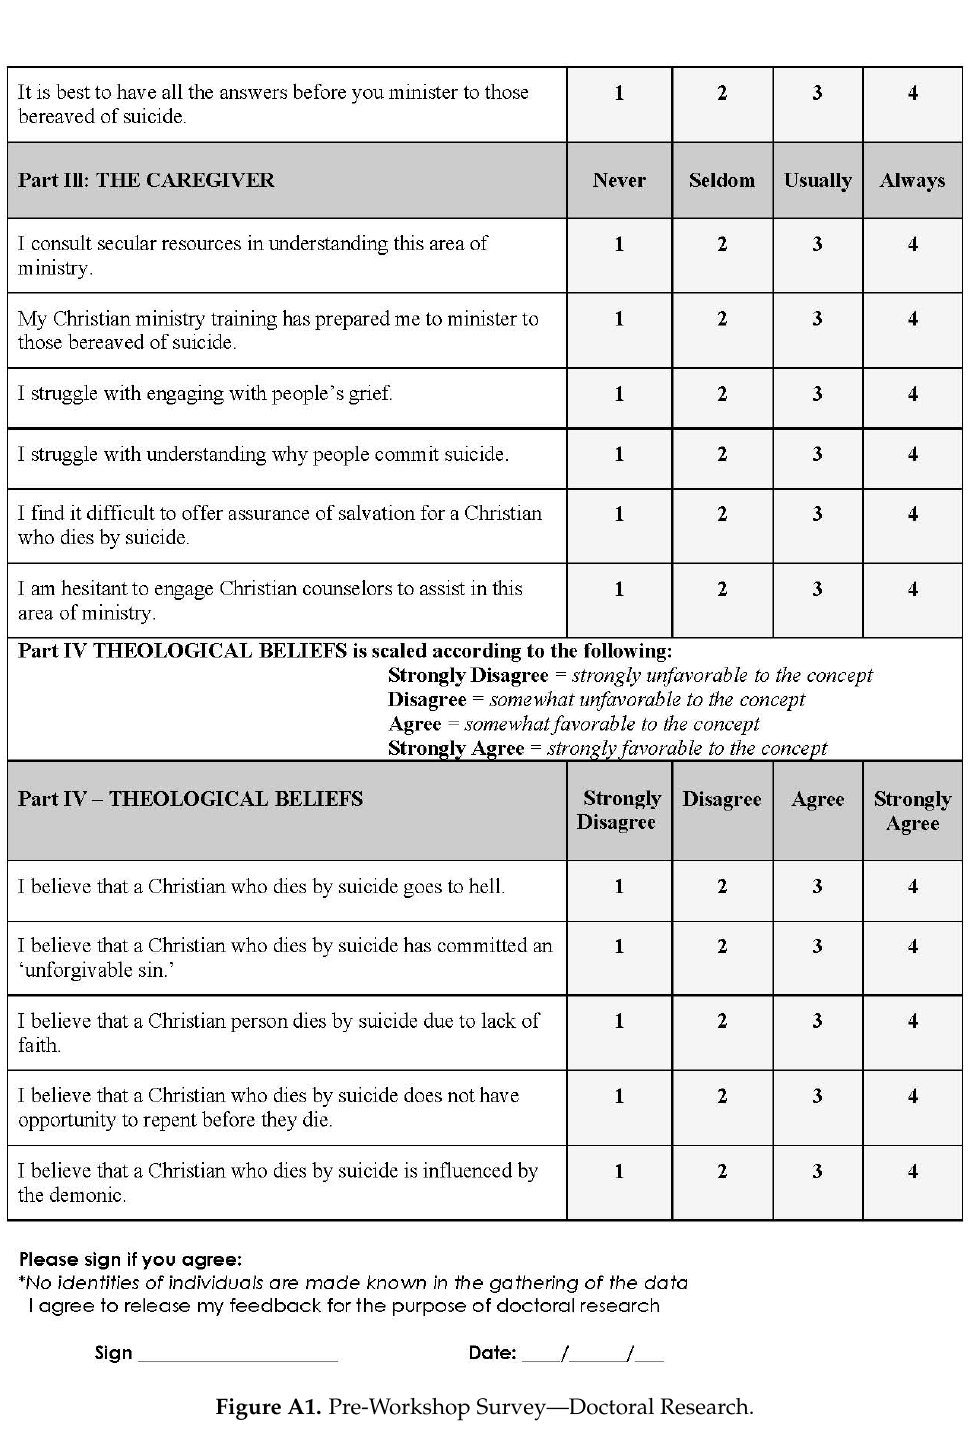
Figure A1. Pre-Workshop Survey—Doctoral Research.